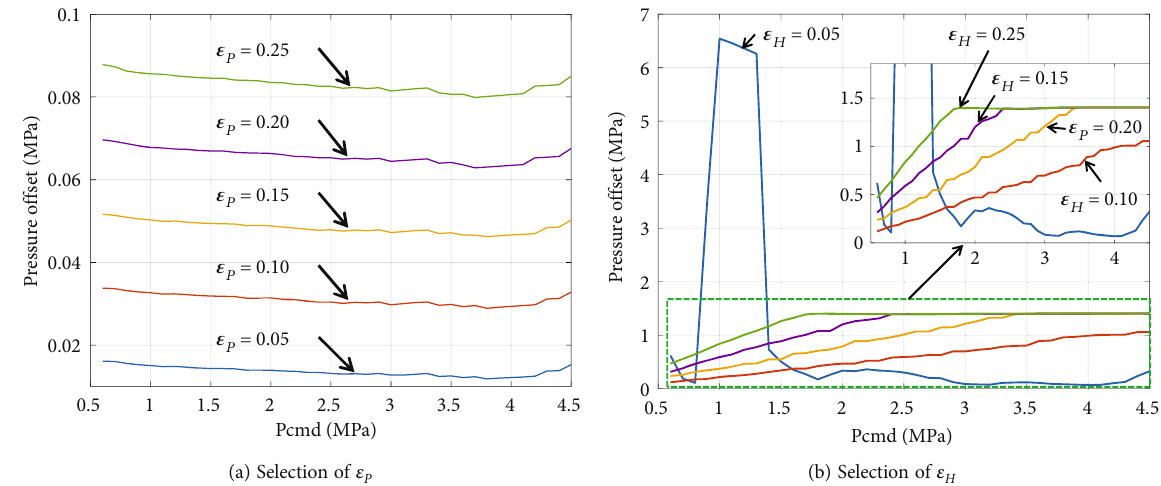
Figure 11: Selection of thresholds for sensor fault